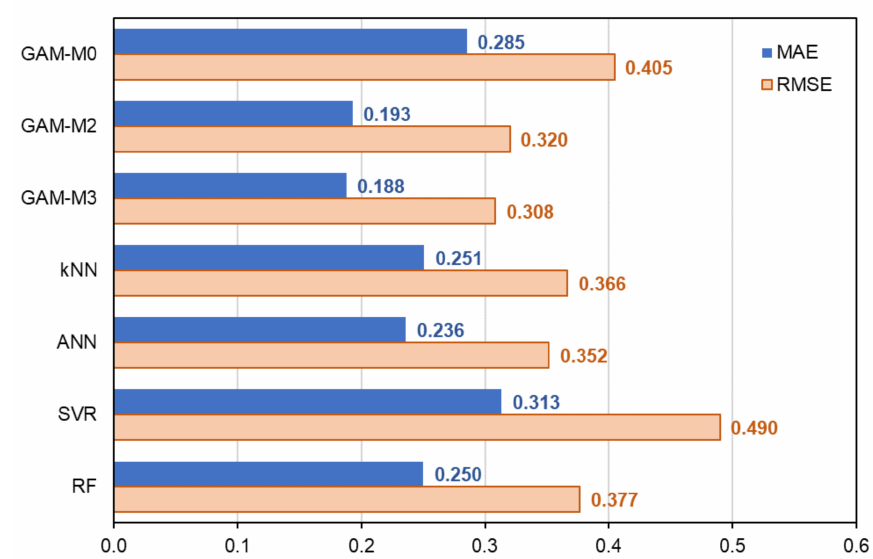
Figure 9. Comparison of forecast errors for the next three months when the model is estimated from nine months of data. Note: The in-sample period is 9 months, from 1 April to 31 December 2017; the out-of-sample period is 3 months, from 1 January to 31 March 2018 (i.e., this is “Additional validation case 2” in Figure 5). The reason for the absence of GAM-M1 is that model estimation is not possible because of the lack of in-sample data for the same